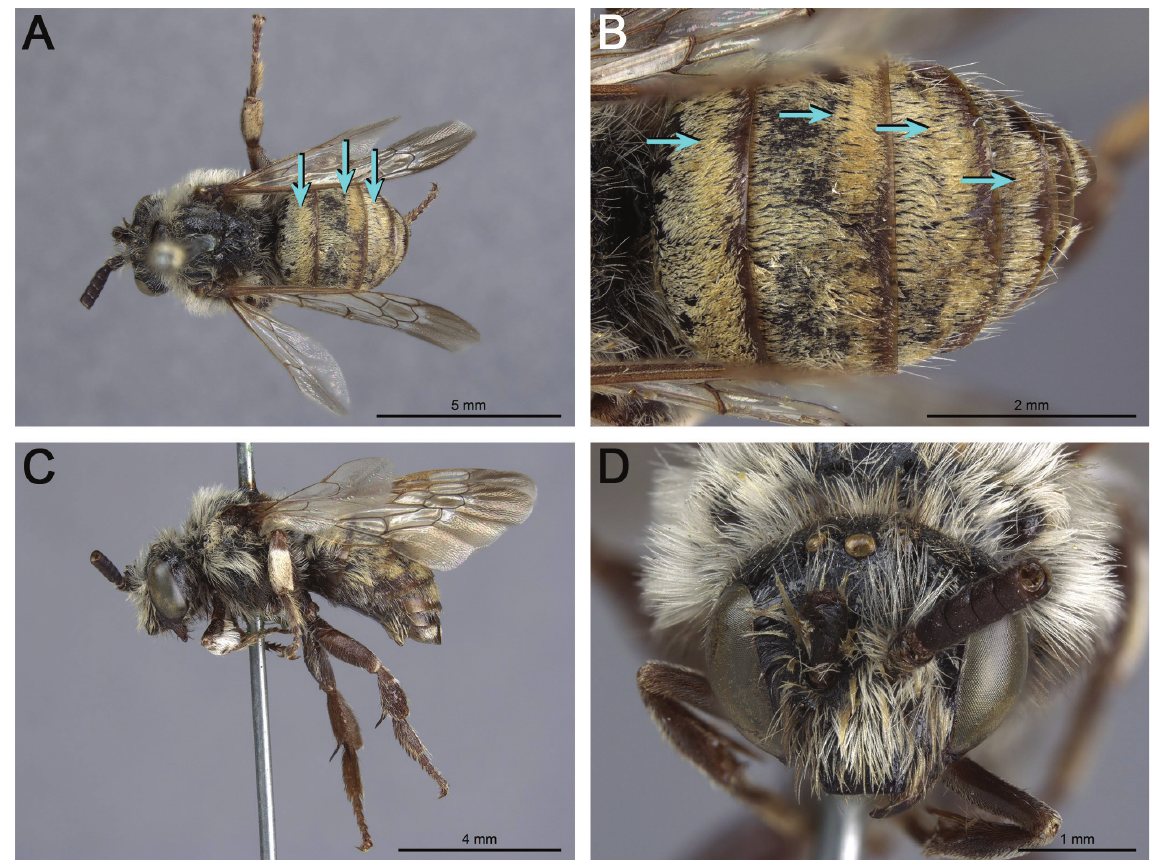
Fig. 7. Melecta ? mucida holotype, ♂ (ANSP 2294) (herein synonymized under B. californica (Cresson, 1878)). A . Habitus, dorsal view (blue arrows indicate apical fasciae of metasomal terga). B . Metasoma, dorsal view (blue arrows indicate apical fasciae of metasomal terga) (pubescence appears to be matted from prior wetting). C . Habitus, lateral view. D . Head, frontal